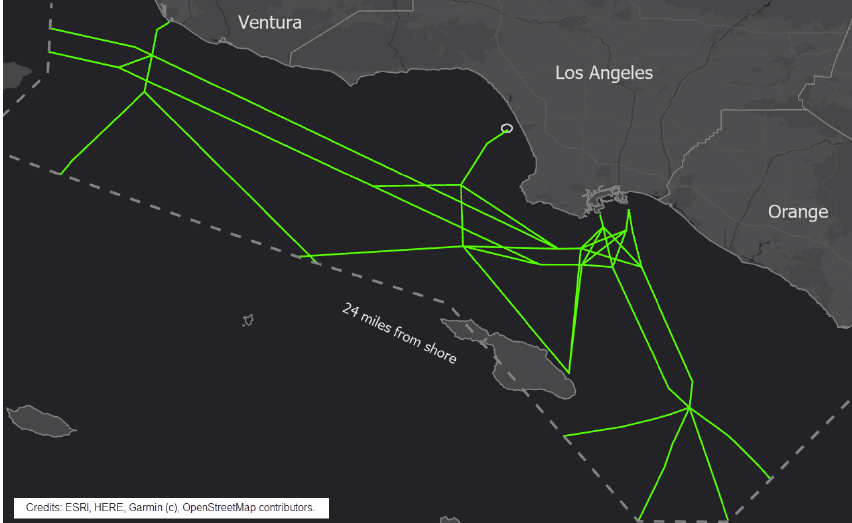
Figure 8. Commercial Marine Vessel (CMV) shipping lanes in Hestia-LA to which Vulcan FFCO 2 underway emissions are allocated (24 miles = 38.6km). © OpenStreetMap contributors 2019. Distributed under a Creative Commons BY-SA